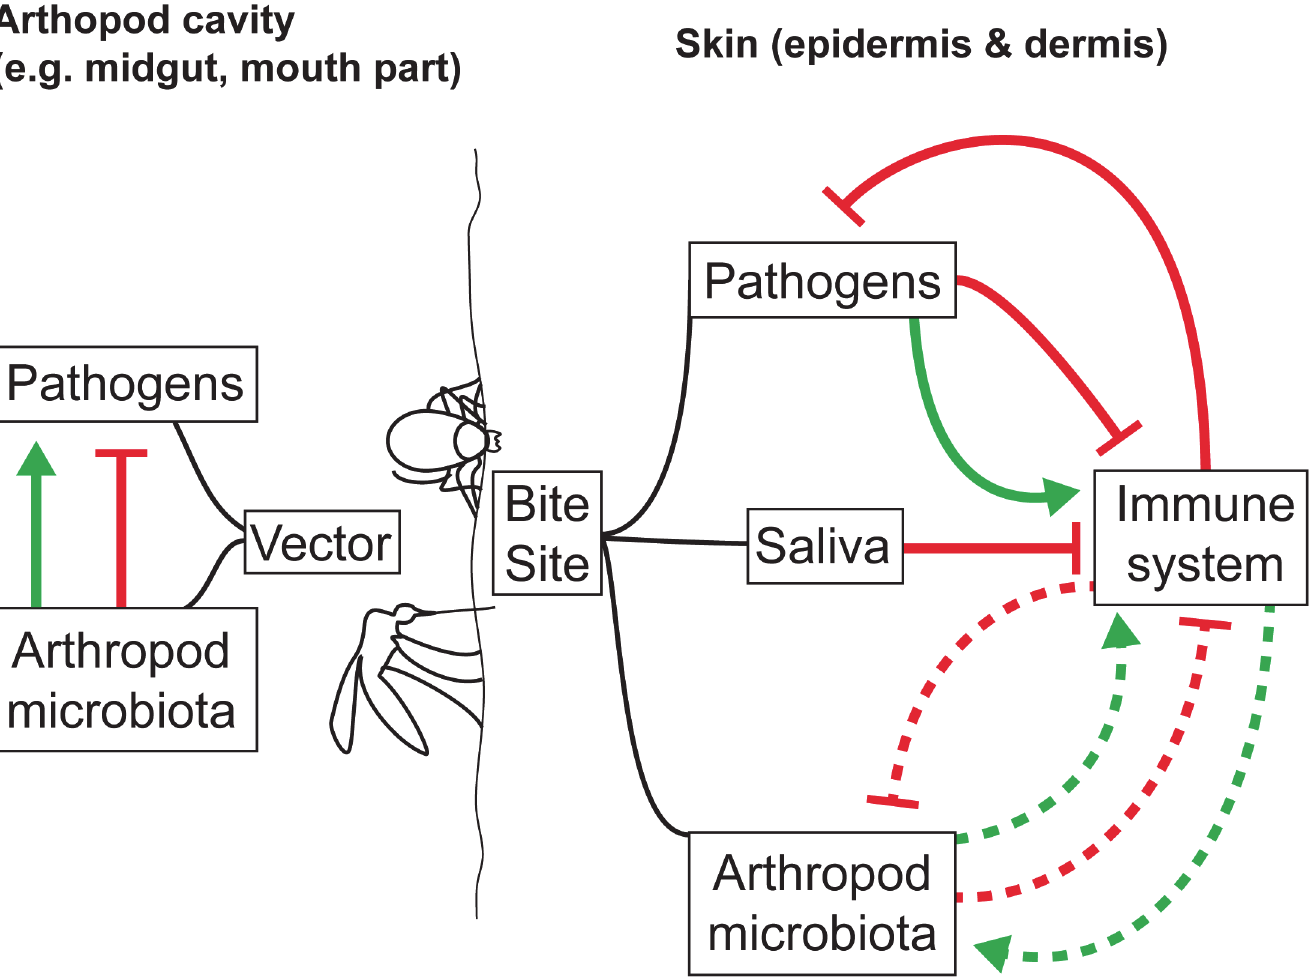
Fig 1. How arthropod microbiota could enhance/interfere with the transmission/establishment of VBDs. In the arthropod cavity, the arthropod microbiota can alter pathogen development, resulting in decreased or increased loads in the vectors and reduced or increased transmission. However, the impact of the pathogens on the microbiota has yet to be assessed. Once transmission has occurred, the host immune system generates a response to destroy the pathogens in the skin. Components from the pathogens themselves and the arthropod saliva are known to actively inhibit this process. The role of the arthropod microbiota, likely transmitted along with the pathogens, on the host immune system is currently unknown (dotted lines).